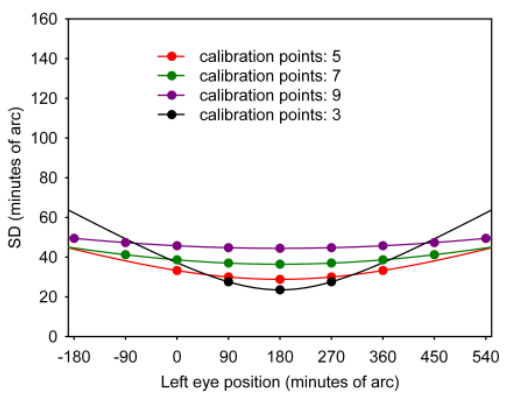
Figure 2: Typical, simulated hyperbola curves for the SD containing 3, 5, 7 or 9 calibration points with constant separation of 90 min arc.